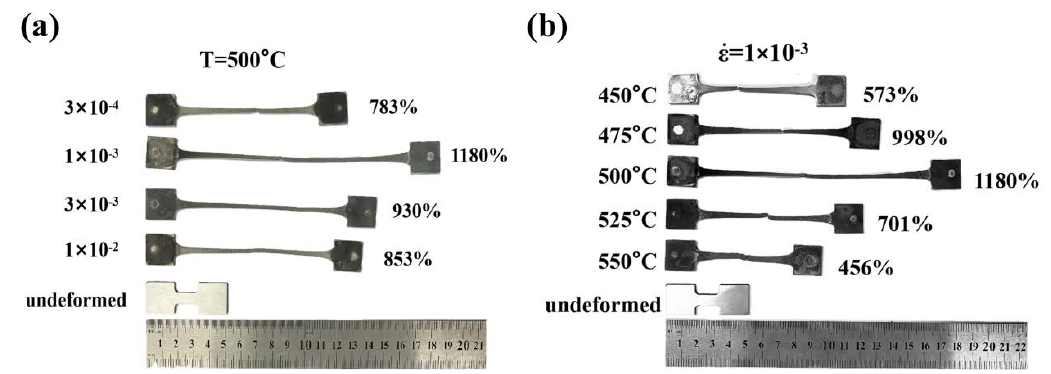
Figure 5. The tensile fractured samples, ( a ) at different strain rates at 500 °C; ( b ) at different temperatures at 1 × 10 −3 s −1 .